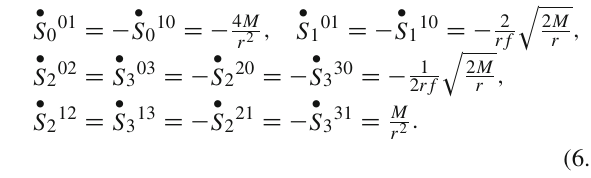
hole mass is given by (4.9),